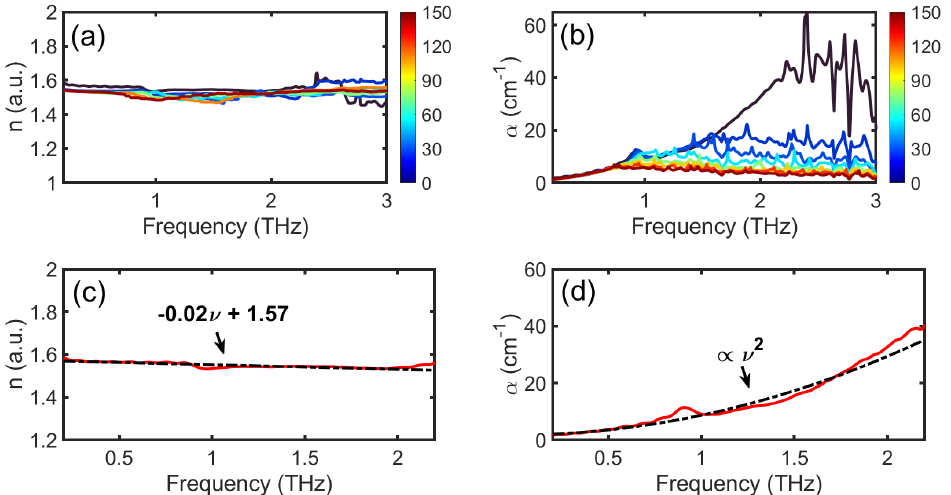
Figure 4. ( a ) Refractive index n ( ν ) and ( b ) attenuation constant α ( ν ) of paper stacks with s = 1 to 155. ( c ) n ( ν ) for s = 10 (by way of example, solid line in red) and a linear fit (dash-dotted line in black). ( d ) α ( ν ) for s = 10 (solid line in red) and a quadratic fit (dash-dotted line in